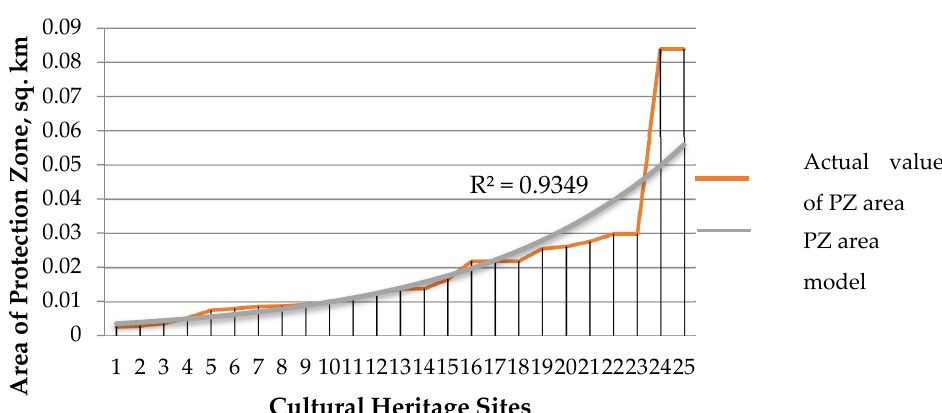
Figure 7. Developing the model of the protection zone.